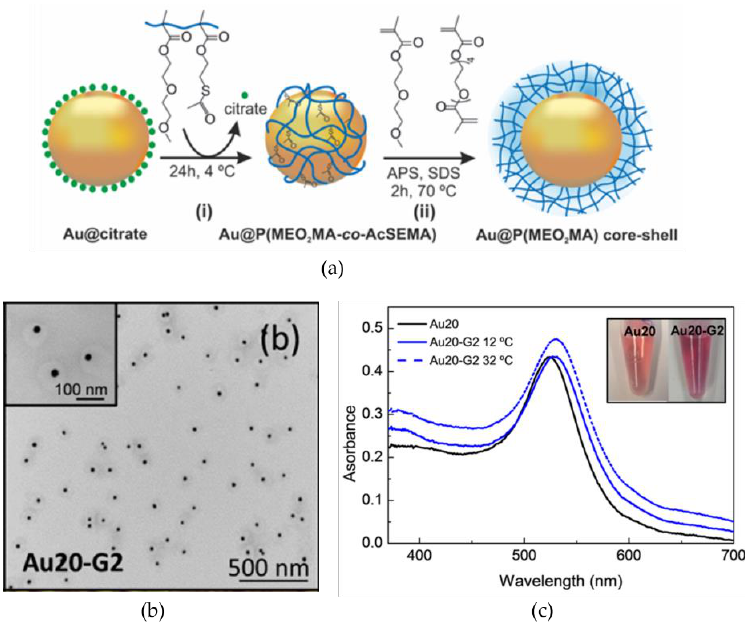
Figure 4. ( a ) Scheme of the preparation for Au@P(MEO 2 MA) particles; ( b ) TEM image of the particles; and ( c ) the optical property of the particles measured at different temperatures. Reproduced with permission from Reference [54] (Copyright 2016 American Chemical Society).